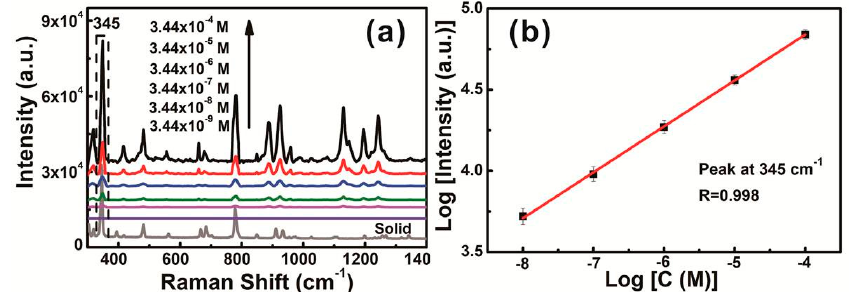
Figure 10. ( a ) The surface enhanced Raman scattering (SERS) spectra of γ -666 obtained from chestnut-like Au nanocrystal films, the concentrations varying from 3.44 × 10 − 4 M to 3.44 × 10 − 9 M, and drying. The bottom curve is the spectrum of solid γ -666. The objective was 50× telephoto, laser power was 2 mW, and the acquisition time was 5 s. ( b ) The relationship between SERS intensity I at 345 cm − 1 and concentration C meets the double logarithm linear. R is the correlation coefficient.